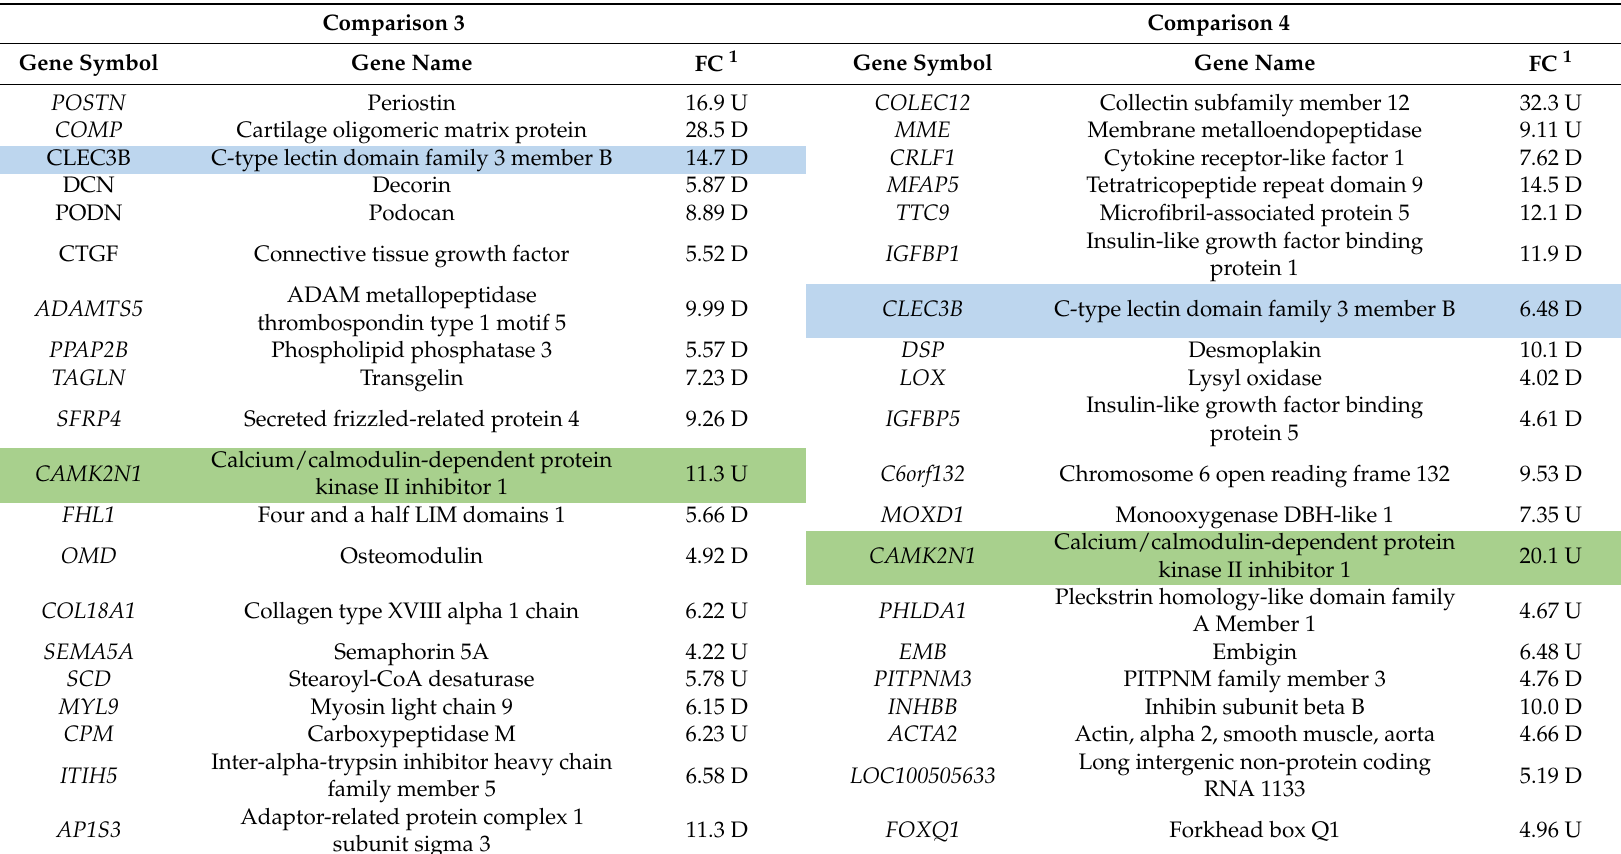
Table 3. Top 20 differentially expressed genes in comparisons 3 and